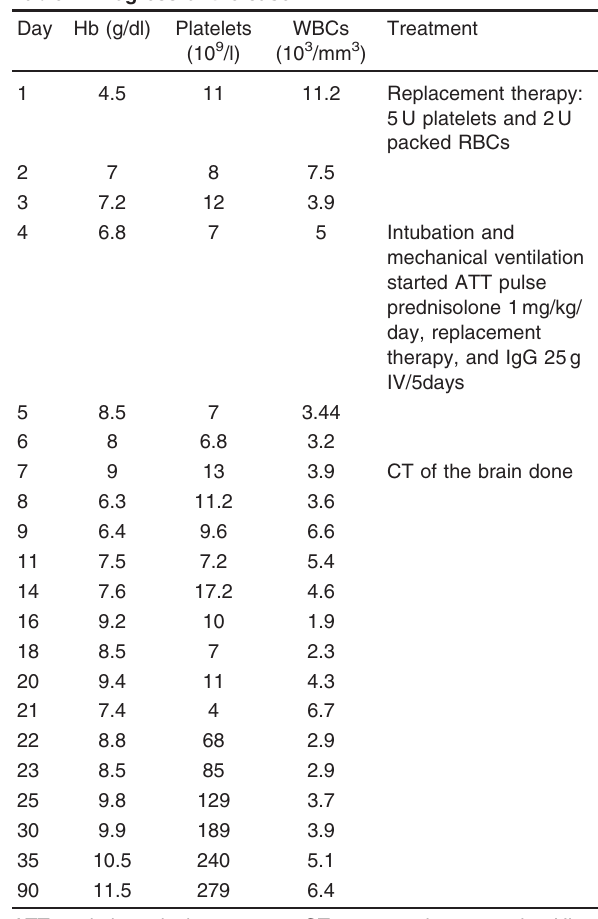
Histopathology of LN represent casting